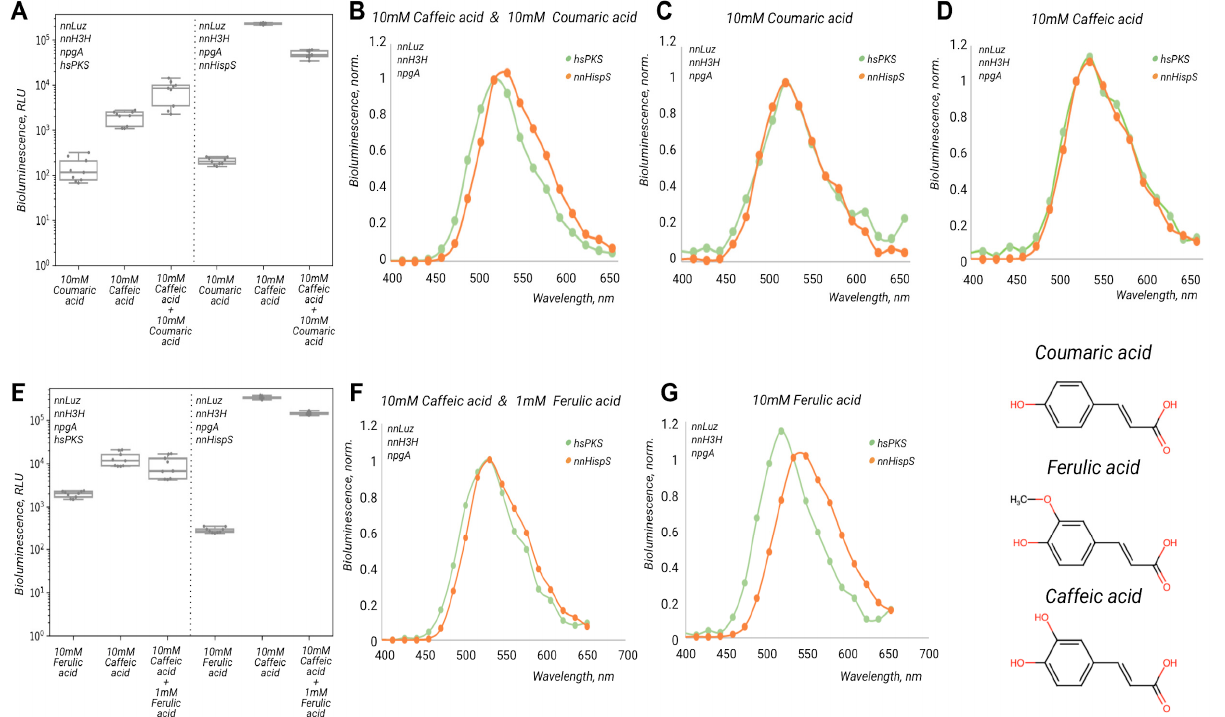
Figure 4. ( A ) Luminescence of Pichia pastoris colonies expressing nnLuz, nnH3H, npgA, and either full-length hsPKS (green) or nnHispS (orange), after treatment with coumaric acid, caffeic acid, or their equimolar combination. Bioluminescence spectra were normalised to 518 nm after treatment with ( B ) caffeic and coumaric acids, ( C ) coumaric acid only, and ( D ) caffeic acid only. ( E ) Integral luminescence of yeast colonies after treatment with ferulic acid, caffeic acid, or their equimolar combination. Bioluminescence spectra were normalised on 518 nm after treatment with ( F ) caffeic and ferulic acids, and ( G ) ferulic acid only.